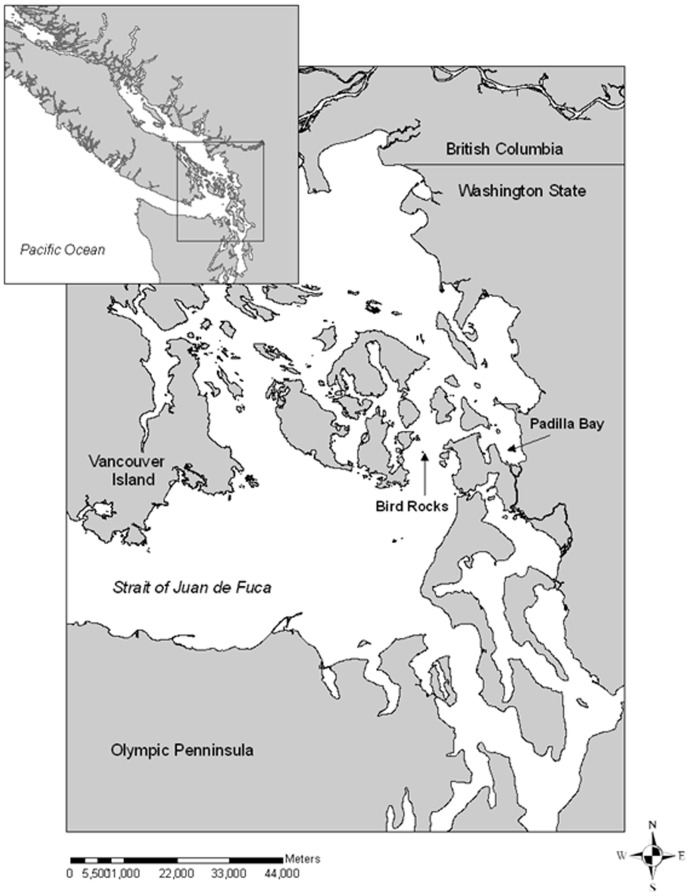
Harbor seal capture sites in the Georgia Basin.Inset: The study area in the Pacific Northwest: the Salish Sea. The Salish Sea encompasses Puget Sound, the San Juan Islands, the Canadian Gulf Islands, the Strait of Juan de Fuca and the Strait of Georgia.